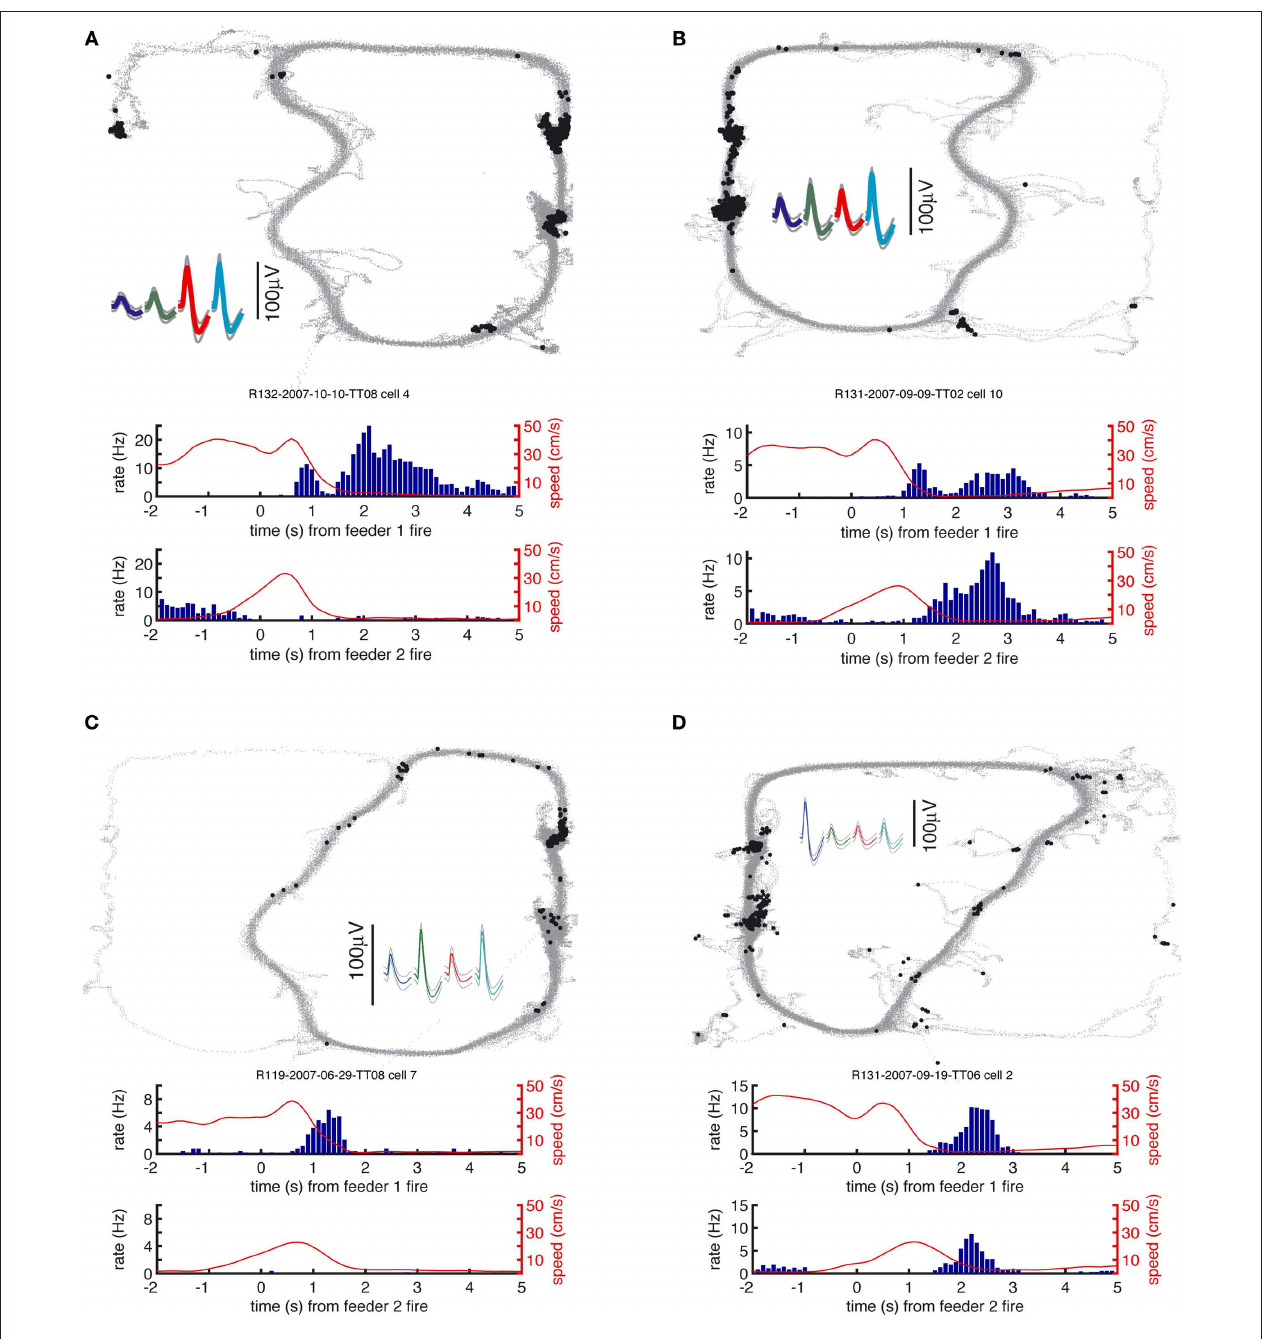
FIGURE 4 | Examples of reward-responsive cells; panel layout as in Figure 3. Reward cells varied in the timing and broadness of the reward response, as well as in whether they responded at one or both of the reward sites. The majority of